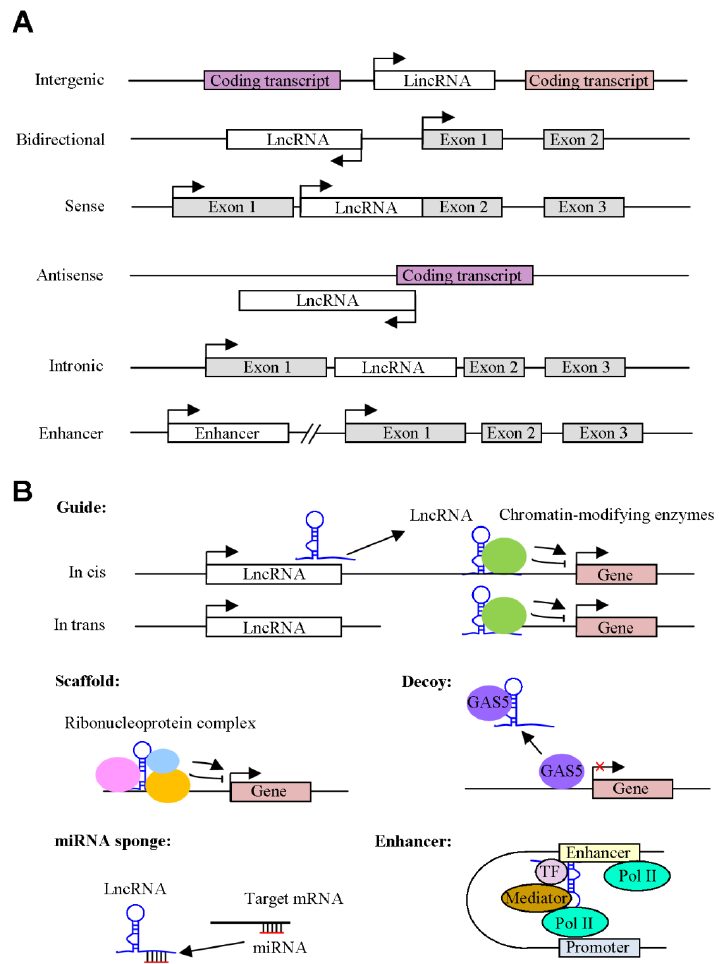
Figure 1. Classifications and actions of Long noncoding RNAs (lncRNAs) in cancer. ( A ) A schematic diagram indicating the classification of lncRNAs according to their orientation and position, including intergenic, bidirectional sense, antisense, intronic lncRNAs and enhancer RNAs (eRNAs). The arrow represents the transcription direction. ( B ) The mechanisms of lncRNAs. Guides are lncRNAs that can recruit specific proteins to target genes, either in cis or in trans. Scaffolds are lncRNAs that can associate with multiple proteins to form ribonucleoprotein complexes. This complex may modulate histone modifications such as methylation. Decoys are lncRNAs that can bind to transcription factors or other proteins and are subsequently removed from a specific location. LncRNAs can function as microRNA (miRNA ) sponges to regulate cellular function. Enhancers act as cis-acting elements and contribute to increase the target genes